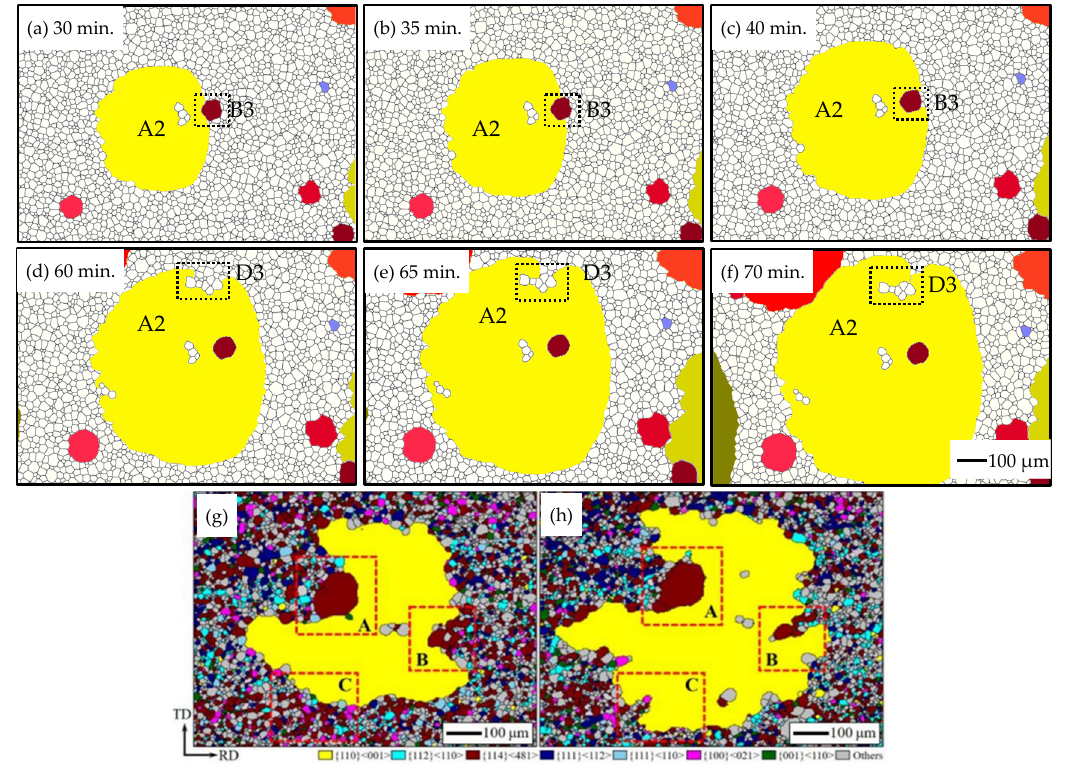
Figure 15. The formation process of island grains in: ( a – f ) simulated results, ( g , h ) experimental observations [49]. A2 is the isolated island grain, D3 is the serial island grain in the simulated results. A is the isolated island grain, B and C are the serial island grains in the experimental observations.